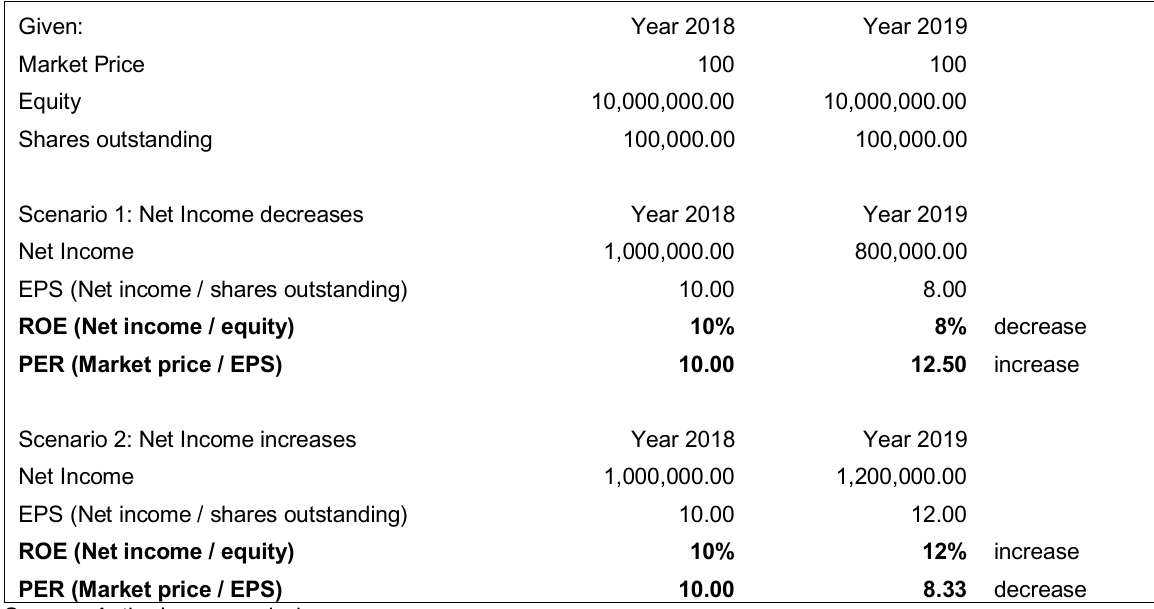
Table 8 : Illustration of Reversal